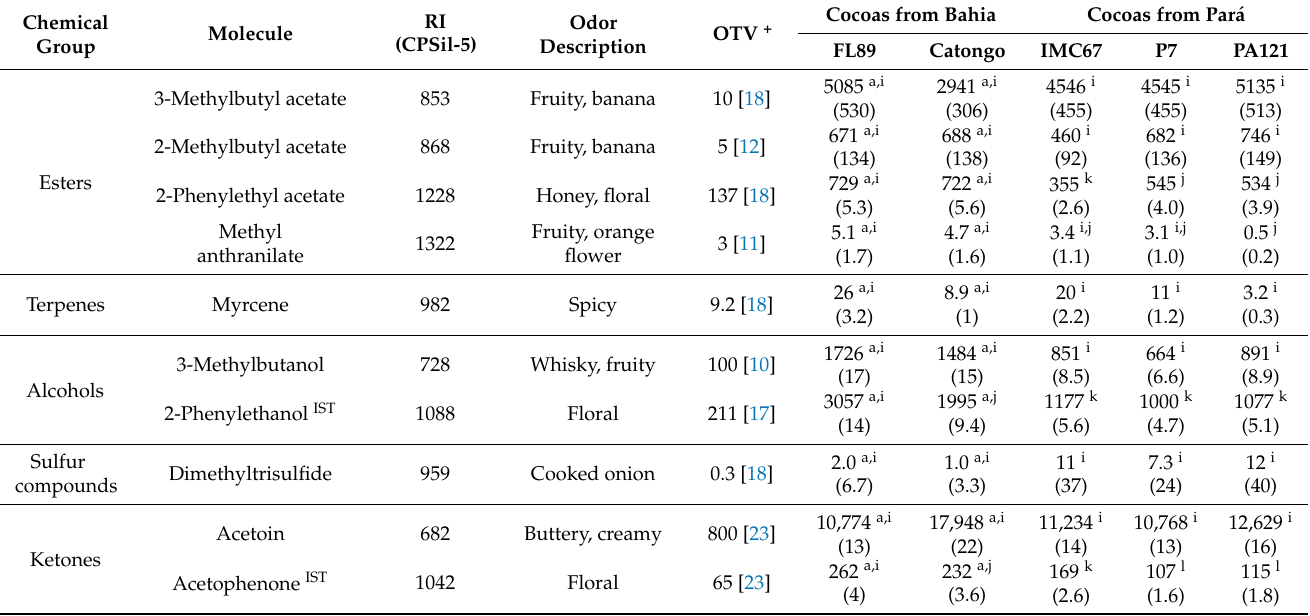
Table 3. GC-EIMS quantification of non-discriminating volatile aroma compounds. Concentrations given in µ g/kg and followed by Odor Activity Values in